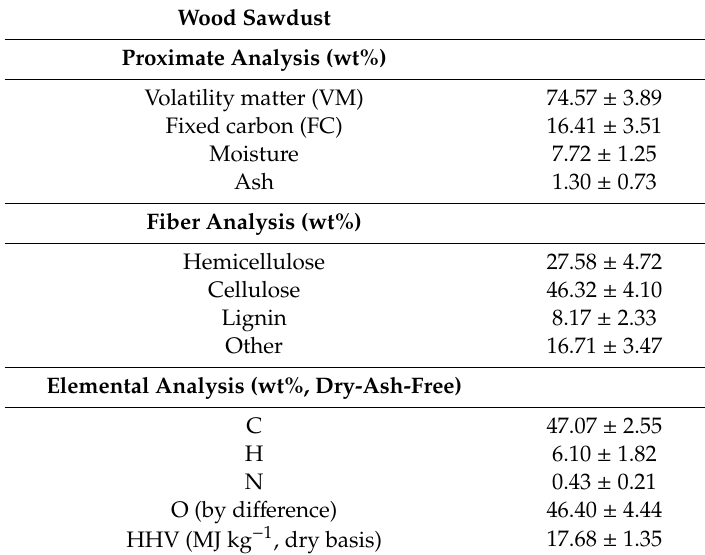
Table 1. Proximate, fiber, elemental, and calorific analyses of raw wood sawdust. Wood Sawdust